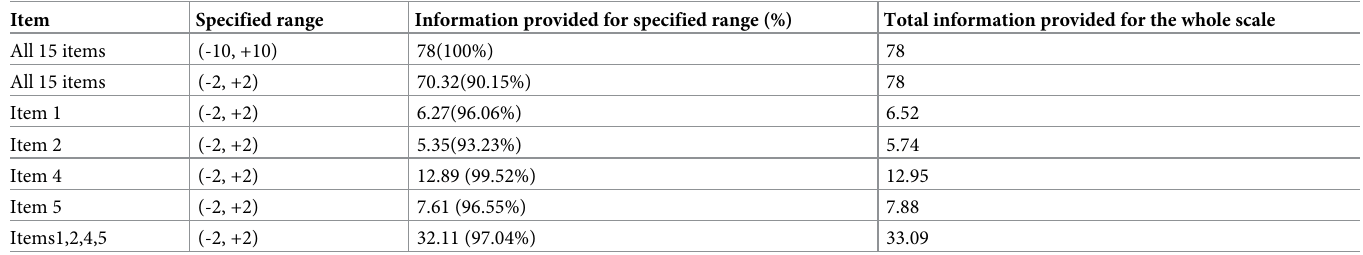
Table 6. Item information provided in specific range of full